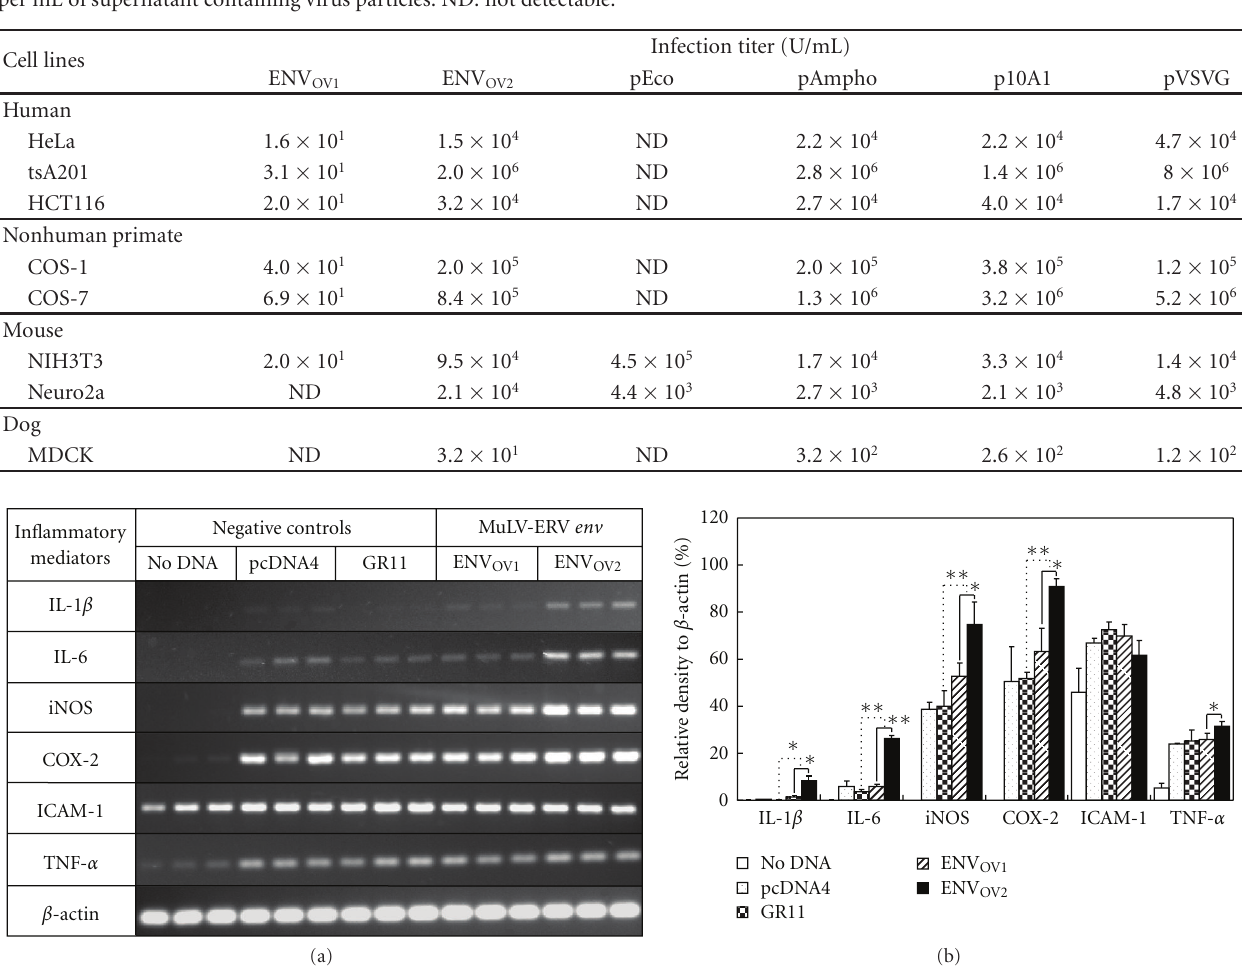
Figure 5: E ff ects of ENV OV1 and ENV OV2 polypeptides on expression of inflammatory mediators. (a) and (b) The e ff ects of the ENV OV1 or ENV OV2 polypeptide in RAW264.7 on the expression of various inflammatory mediators are presented. Di ff erential modulation potentials for inflammatory mediators were observed between ENV OV1 and ENV OV2 polypeptides. The densitometric value of each inflammatory mediator was normalized to β -actin, and a graph was formulated. Three di ff erent forms of negative control were included in this experiment: no DNA, pcDNA4 (blank pcDNA4/HisMax plasmid), and GR11 (similar insert size as ENV OV1 and ENV OV2 : mouse glucocorticoid